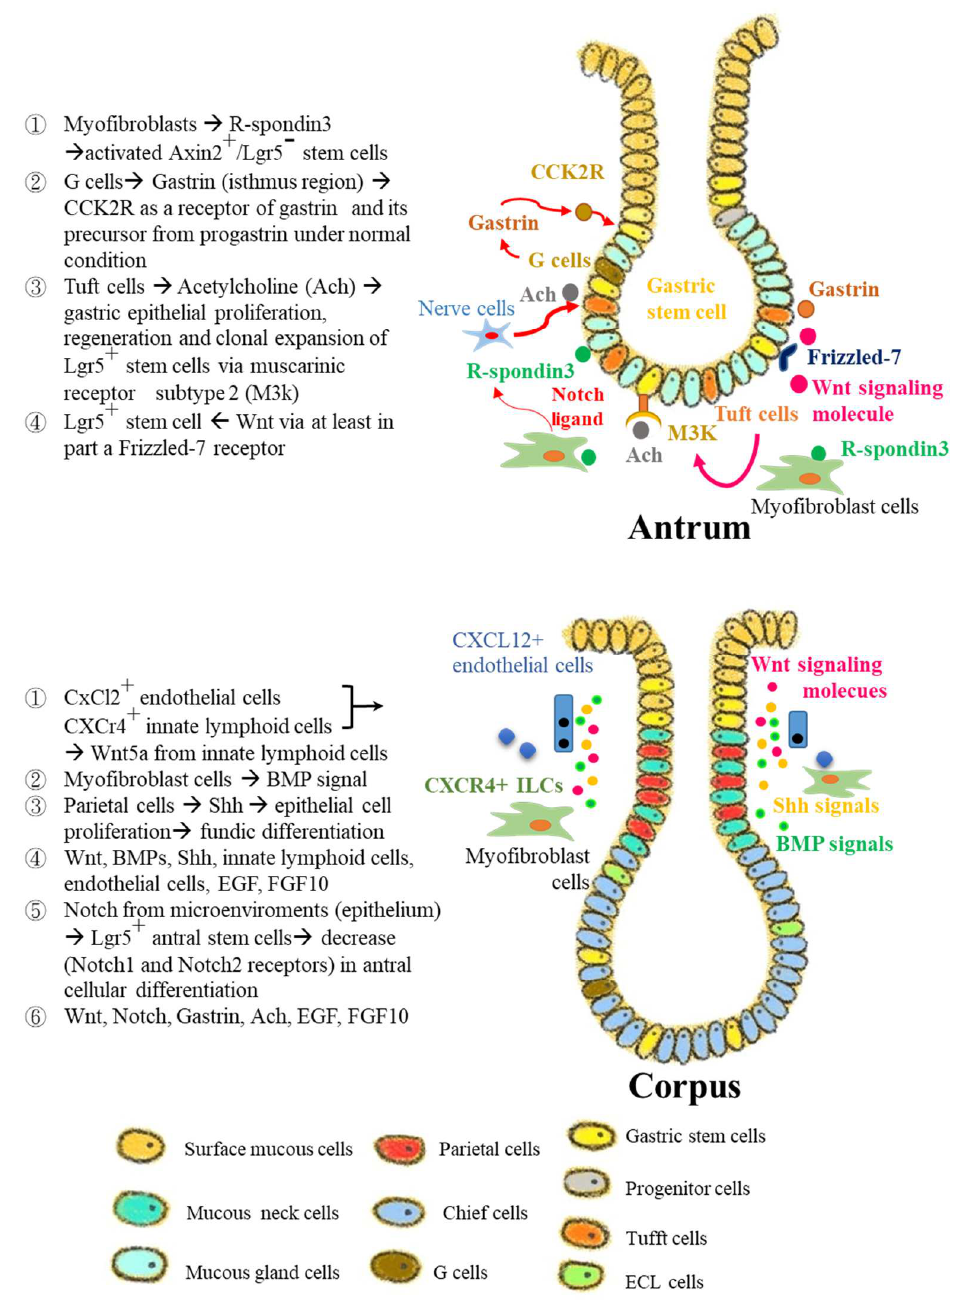
Figure 3. Interaction between gastric stem cells and their microenvironmental factors. In the antrum, Notch signal affects the proliferation and differentiation of stem cells and differentiation.